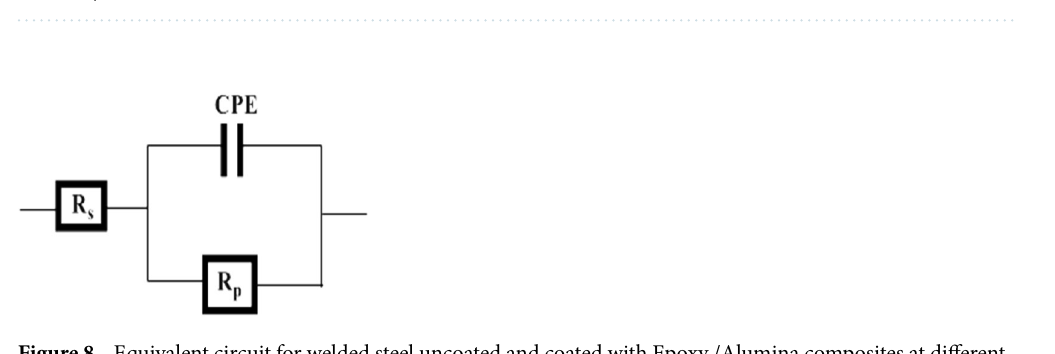
Table 2. charge transfer resistance of melted zone with epoxy/alumina coating in 1 M HCl solution and their efficiency (EI%).